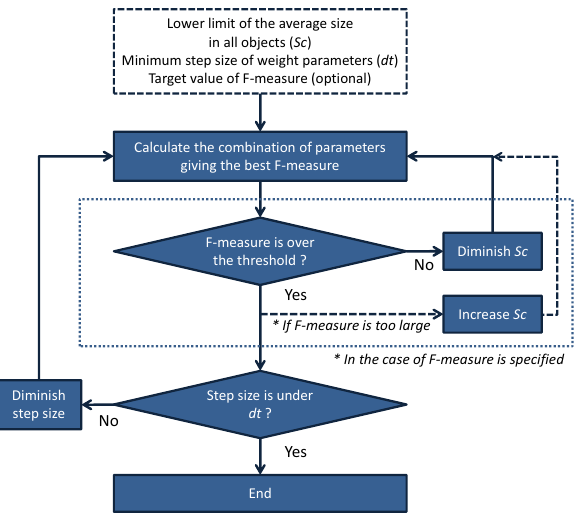
Figure 6. Process flow for automatic parameterization